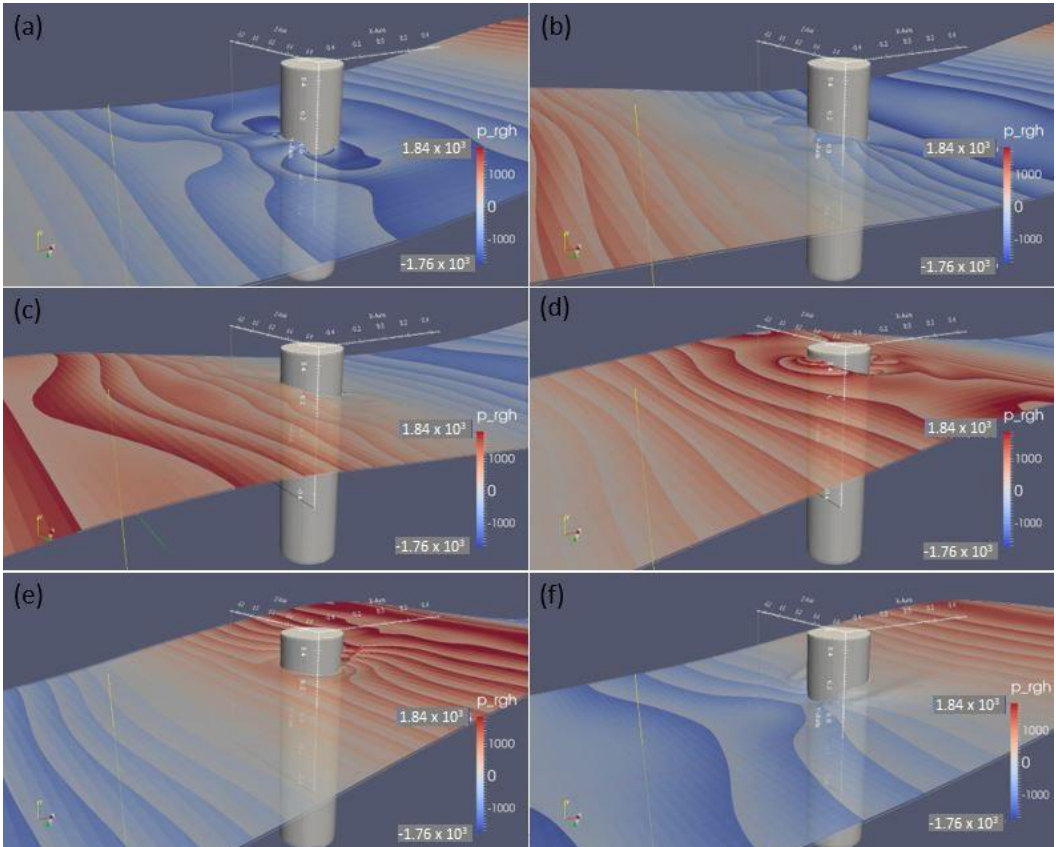
Figure 12. Pressure distribution in the simulation domain from the top, while the cylinder interacts with the incoming wave with simulation time for figure ( a ) 0.28Ts, ( b ) 0.43Ts, ( c ) 0.57Ts, ( d ) 0.71Ts, ( e ) 86Ts and ( f ) 1Ts. The flow field pressure distribution is for case 9, with wave period of T = 2.50 s and wave height of H = 0.46 m. J. Mar. Sci. Eng. 2020 , 8 , x FOR PEER REVIEW